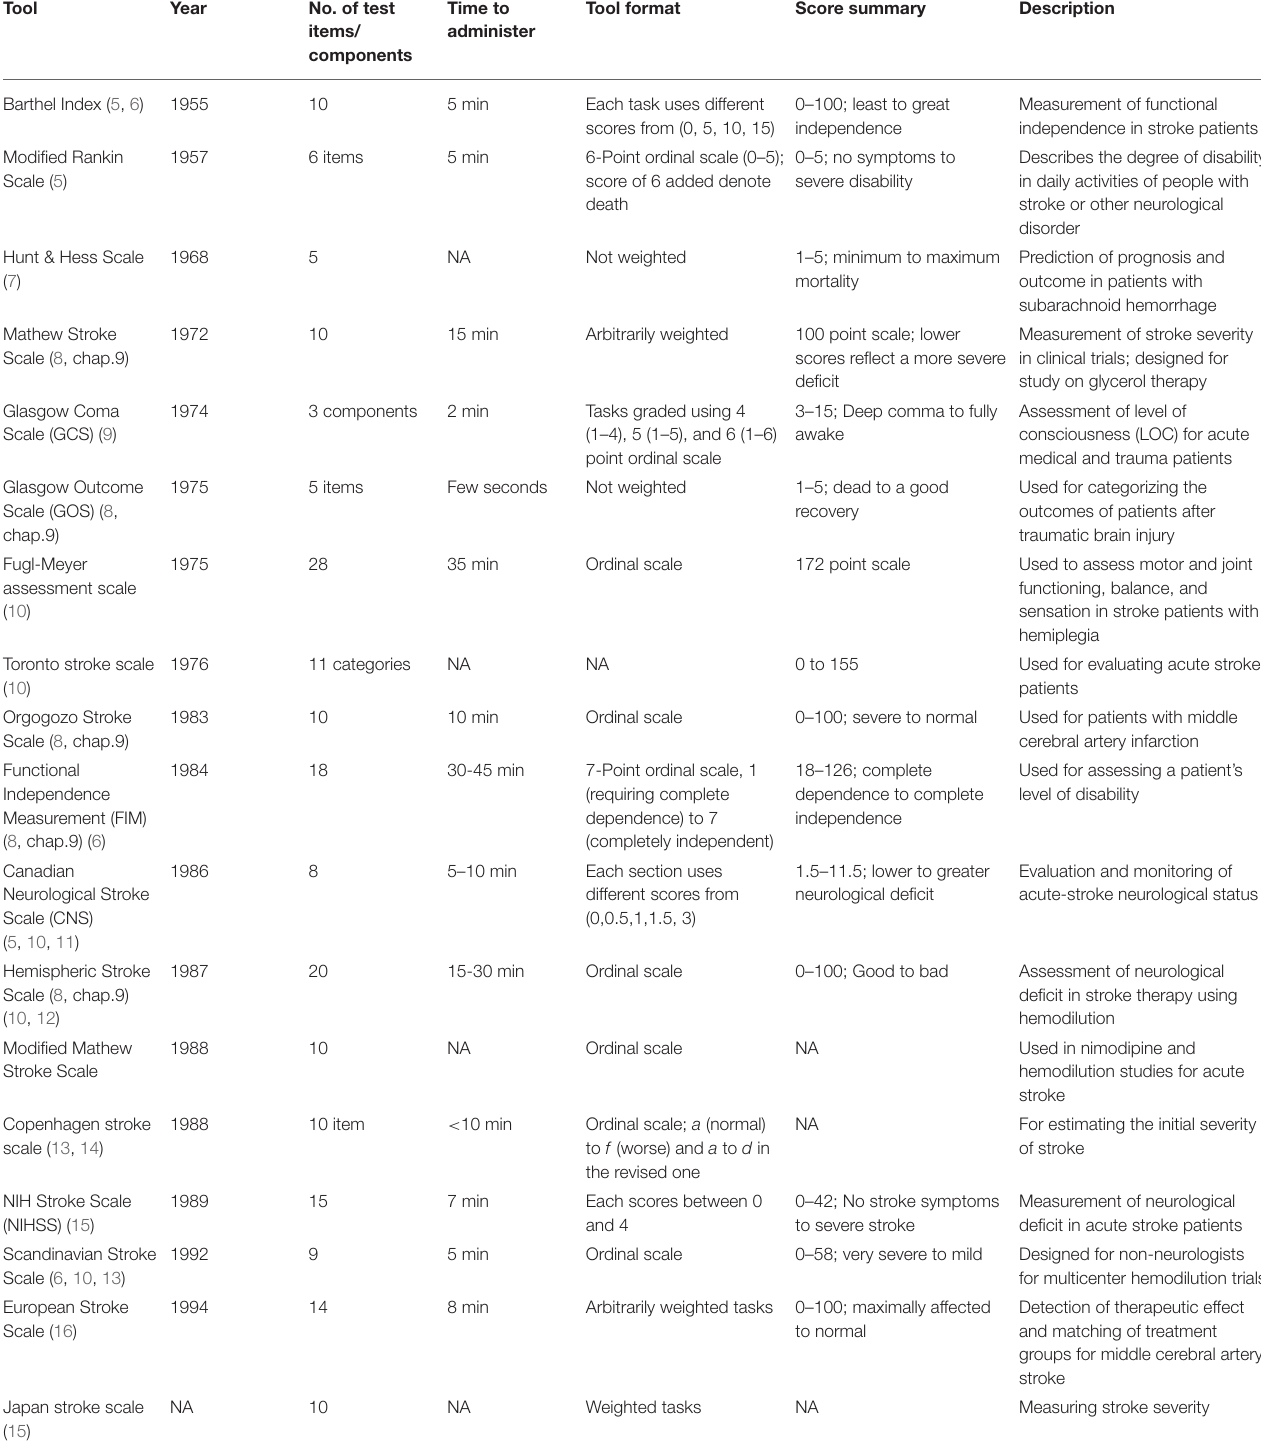
TABLE 1 | Stroke scales and